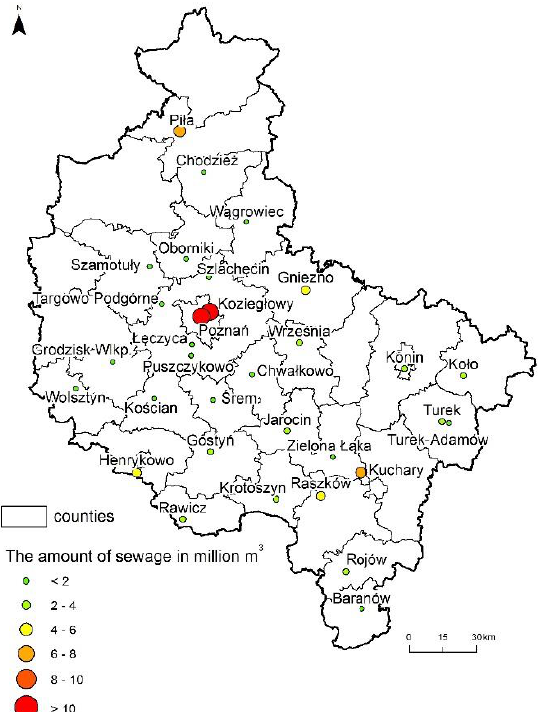
Figure 12. Location of sewage treatment plants with a minimum capacity of 1 million m 3 per year (own calculations).